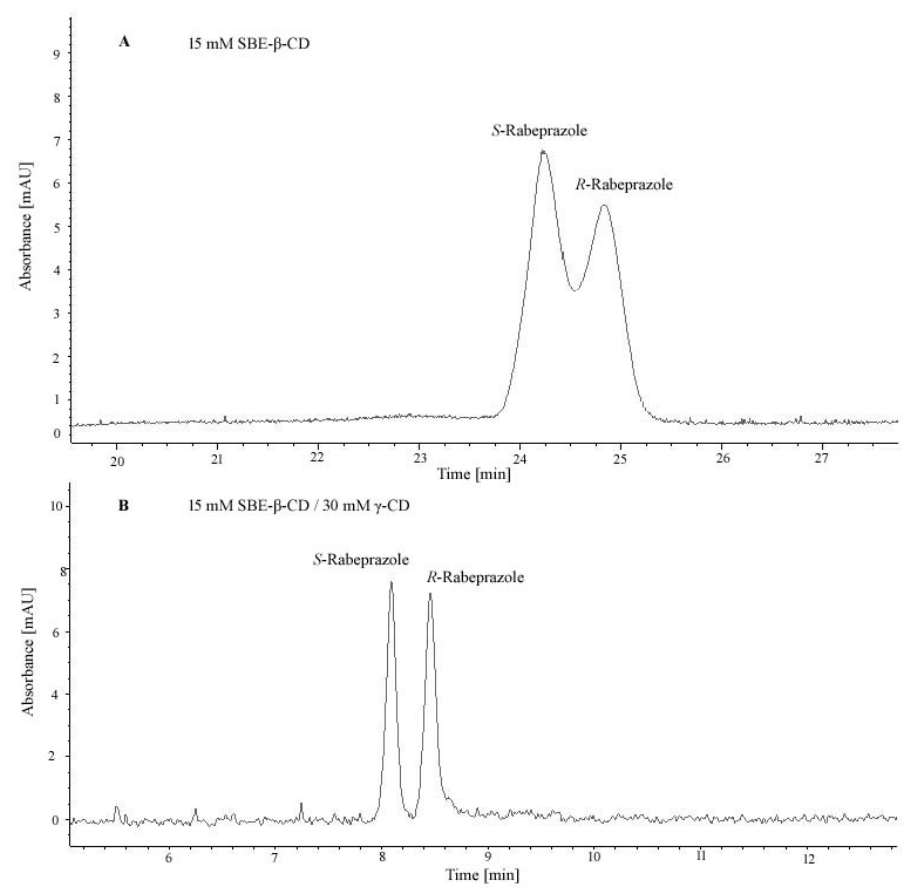
Figure 3. Chiral separation of rabeprazole enantiomers by CE in single and dual CD systems (( A )—CS 15 mM SBE- β -CD, ( B )—CS 15 mM SBE- β -CD/30 mM γ -CD; experimental conditions: 25 mM phosphate BGE, pH = 7.0, +20 kV voltage; 18 °C temperature; 50 mbar/3 s injection, detection at 210 nm).